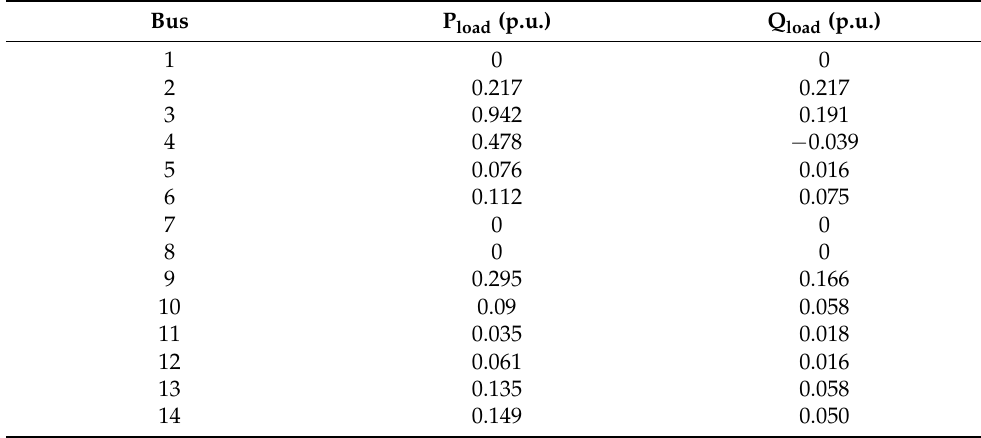
Table 3. IEEE 6- bus test system load values .